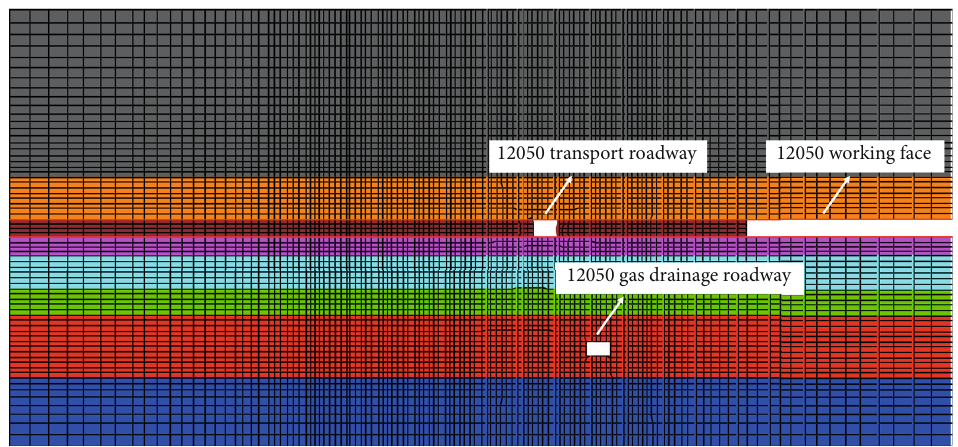
Figure 15: Numerical calculation model of internal staggered arrangement.